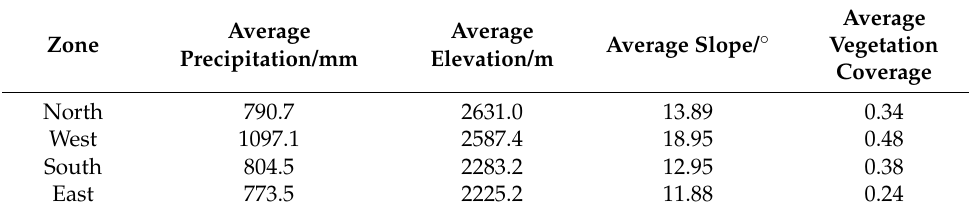
Figure 5. Watershed division and selection of sub-watersheds. Basin division of the Erhai Lake ( a ), the watershed upstream of the LC station of the MJ ( b ), YX, BS, and MC watershed in the west region ( c ), BL watershed in the south region ( d ), and YL watershed in the east region ( e ). Table 2. Zone overview of Lake Erhai